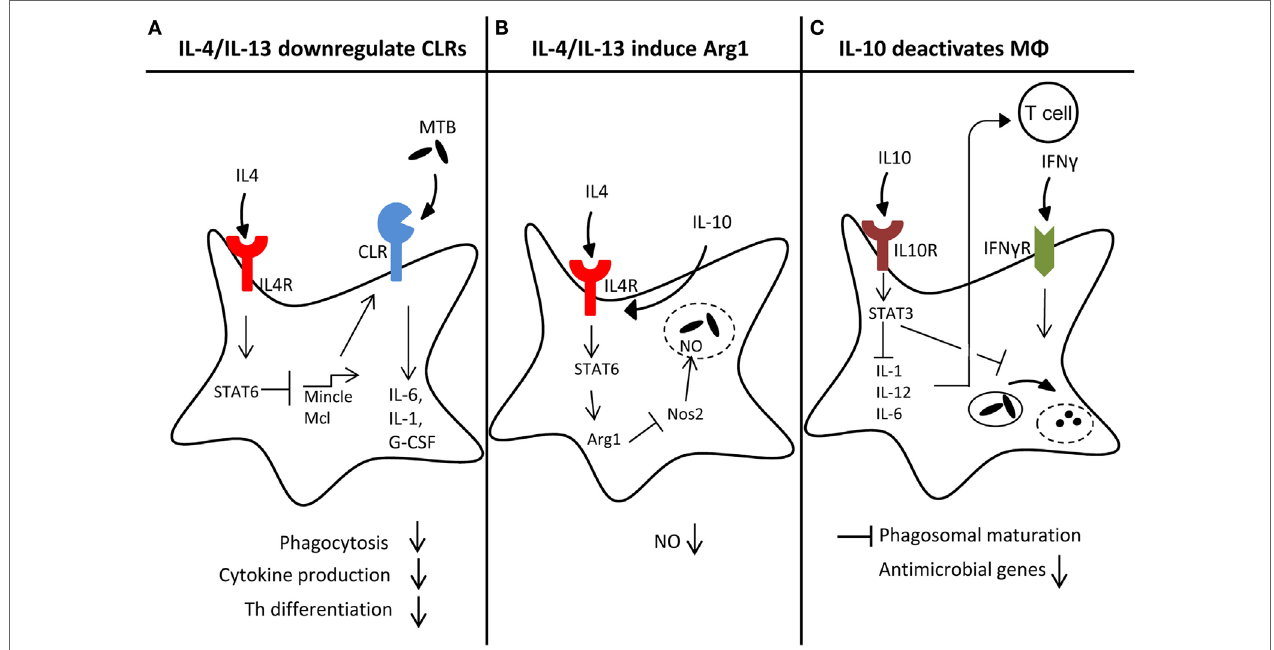
FiGURe 2 | Macrophage reprogramming by helminth-induced type 2 responses. Helminth-induced type 2 responses can act on macrophages on different levels, thereby impeding antimicrobial responses toward Mycobacterium tuberculosis (MTB): (A) high levels of IL-4/IL-13 downregulate C-type lectin receptor (CLR) expression in a Stat6-dependent manner, which may lead to reduced amounts of pro-inflammatory cytokines like IL-6, IL-1, or G-CSF, impaired phagocytosis and Th1/Th17 differentiation. (B) Simultaneously, IL-4/IL-13 signaling through Stat6 strongly induces Arginase1 (Arg1), which counteracts Nos2 through substrate depletion, leading to reduced NO production and less effective killing of MTB inside the phagolysosome. (C) The anti-inflammatory cytokine IL-10, produced during helminth infection, can delay phagosomal maturation. Moreover, IL10R signaling through STAT3 inhibits IL-1, IL-12, or IL-6 expression, which in turn inhibits Th1